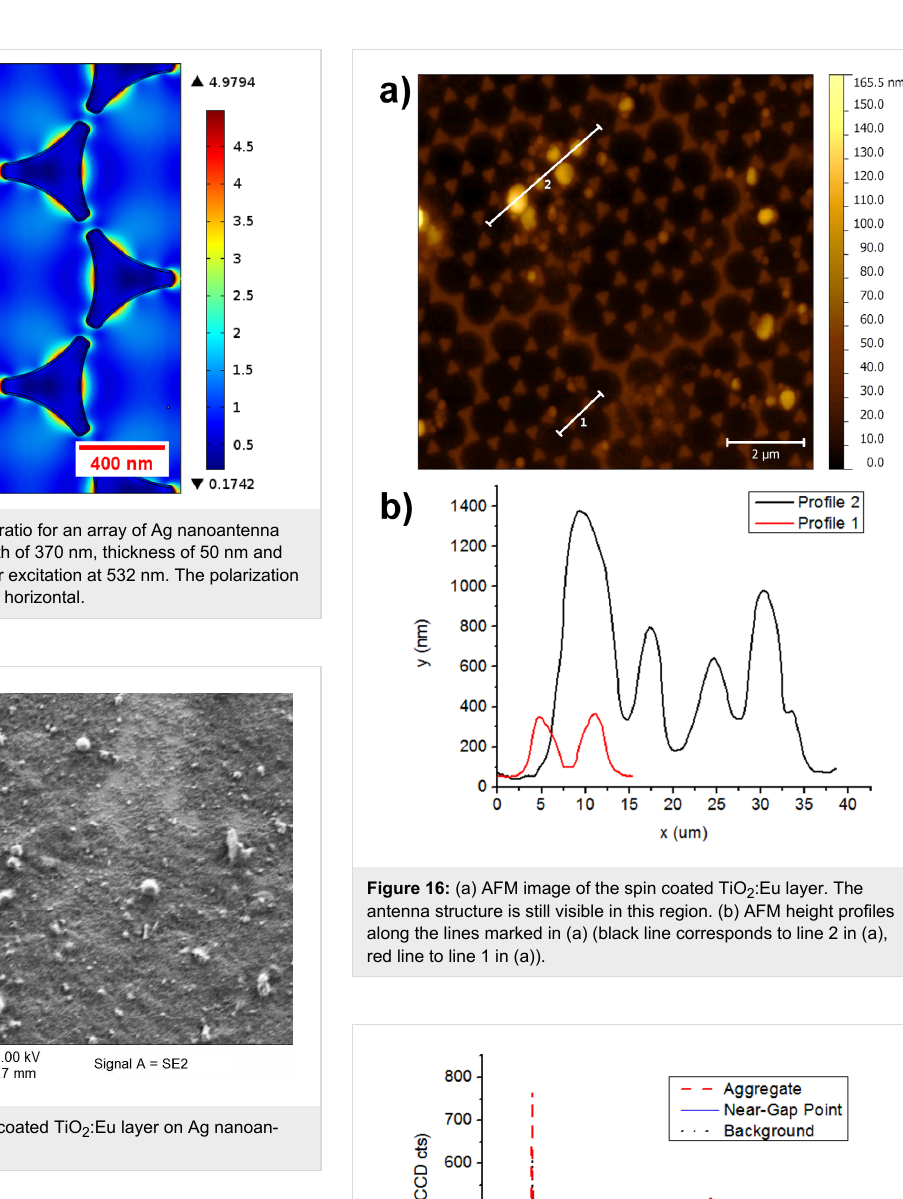
an SEM image of the spin-coated TiO 2 :Eu particles. The